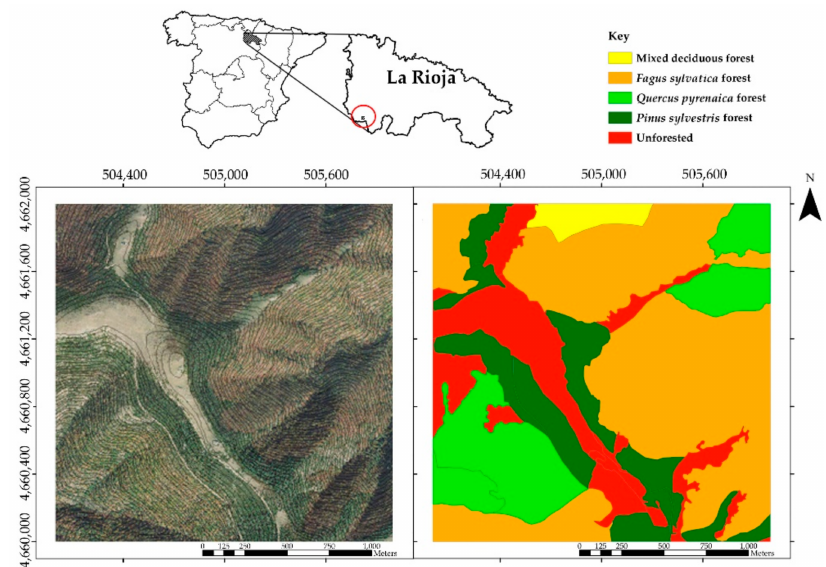
Figure 1. Area of interest with location map. Left: orthophoto of the study area with superimposed topographic map with contour lines ranging 1220–1780 m above sea level, at 10 m intervals. Right: vegetation cover types from the Spanish National Forest Map. Universal Transverse Mercator (UTM) zone 30 N coordinates (m) in the